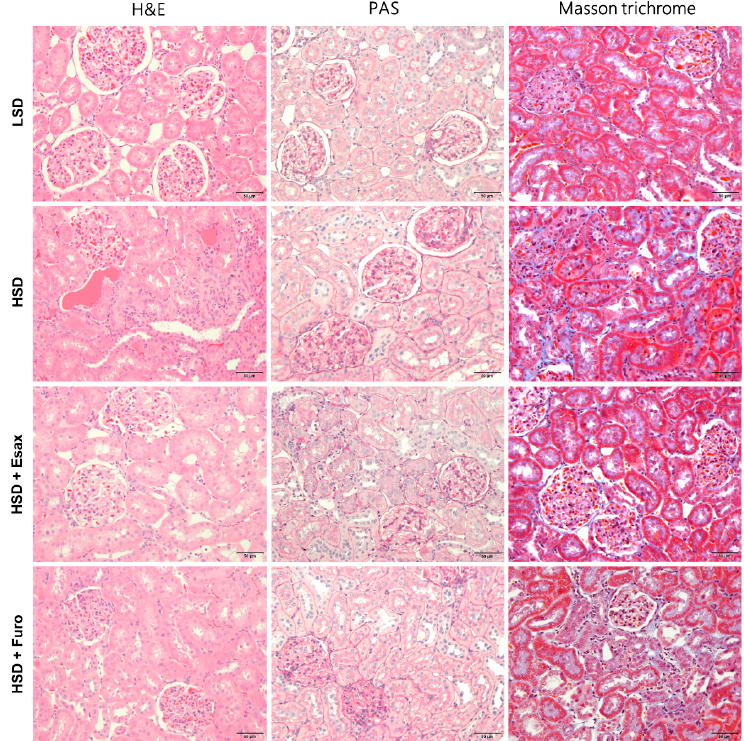
Figure 5. Renal histological staining. Representative images of hematoxylin and eosin, periodic acid–Schiff (PAS), and Masson trichrome staining of the renal cortex.